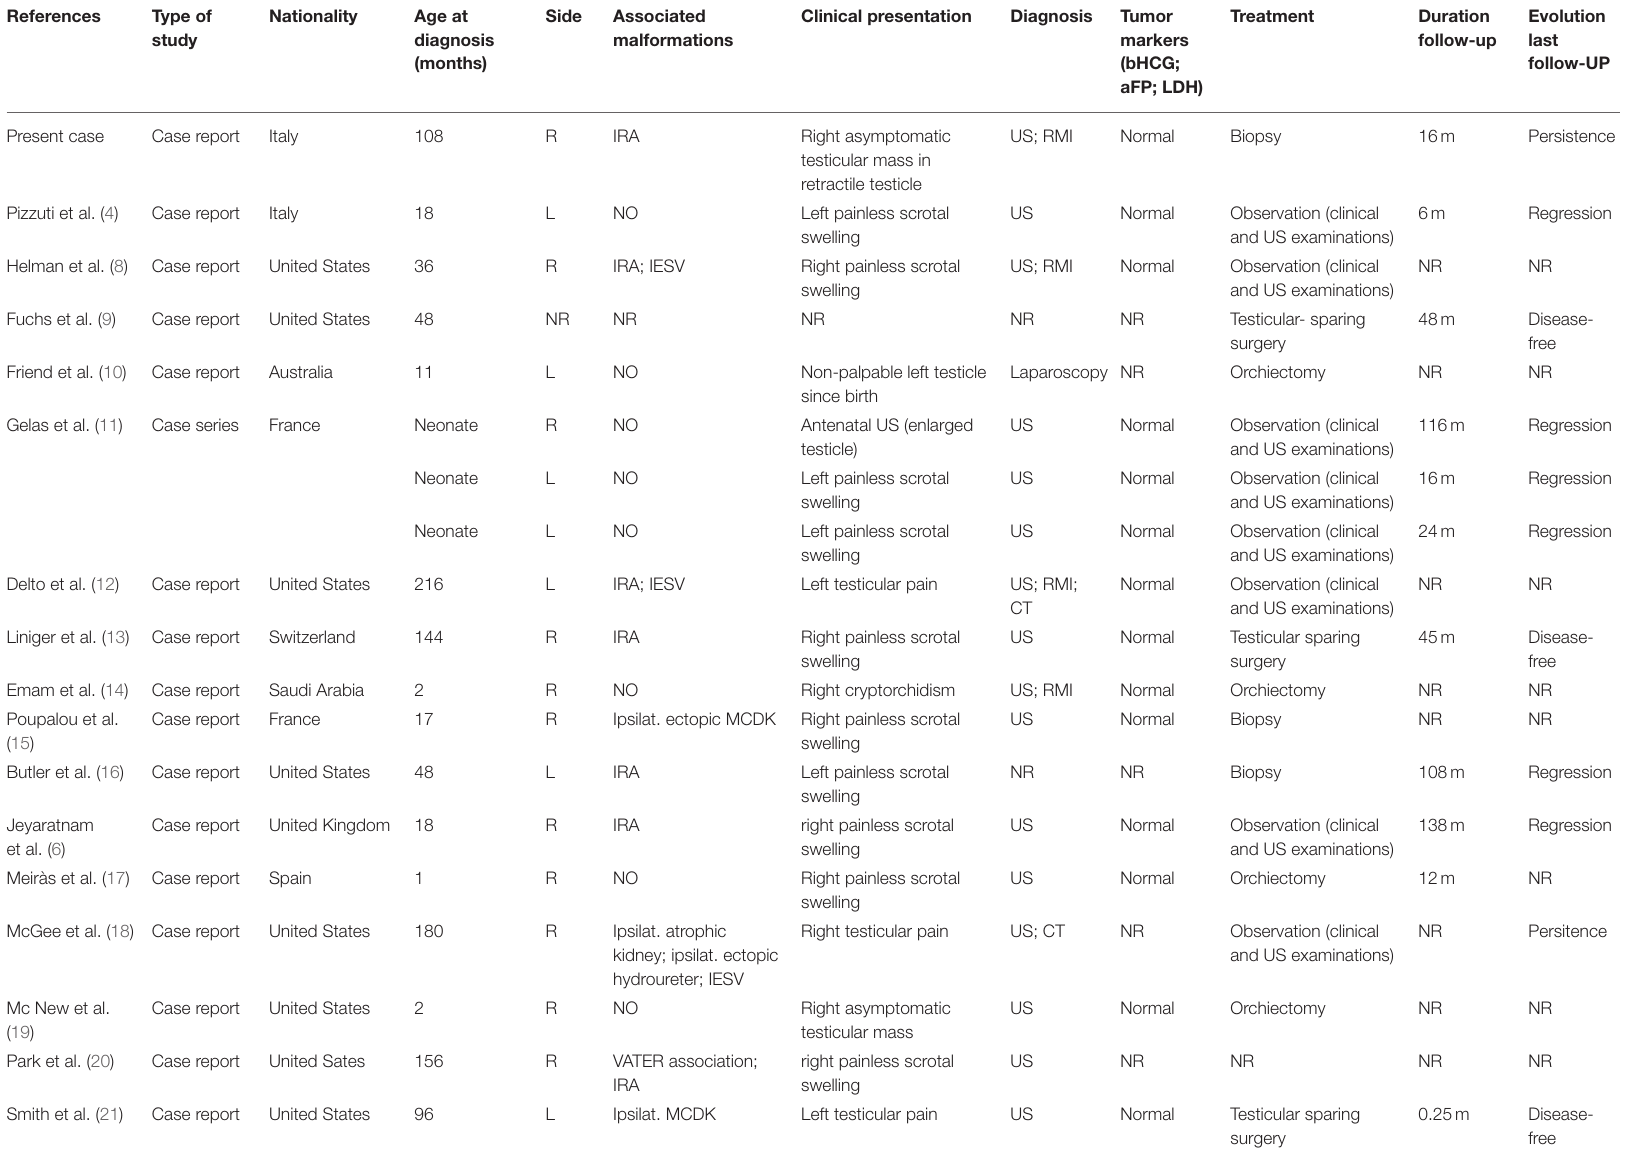
TABLE 1 | Characteristics of studies included in the